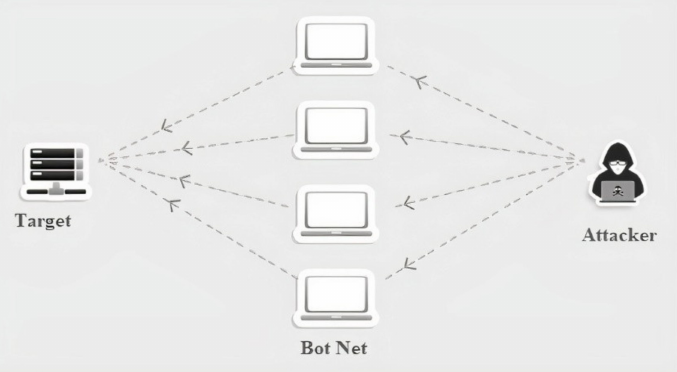
Figure 1. A botnet-driven DDoS